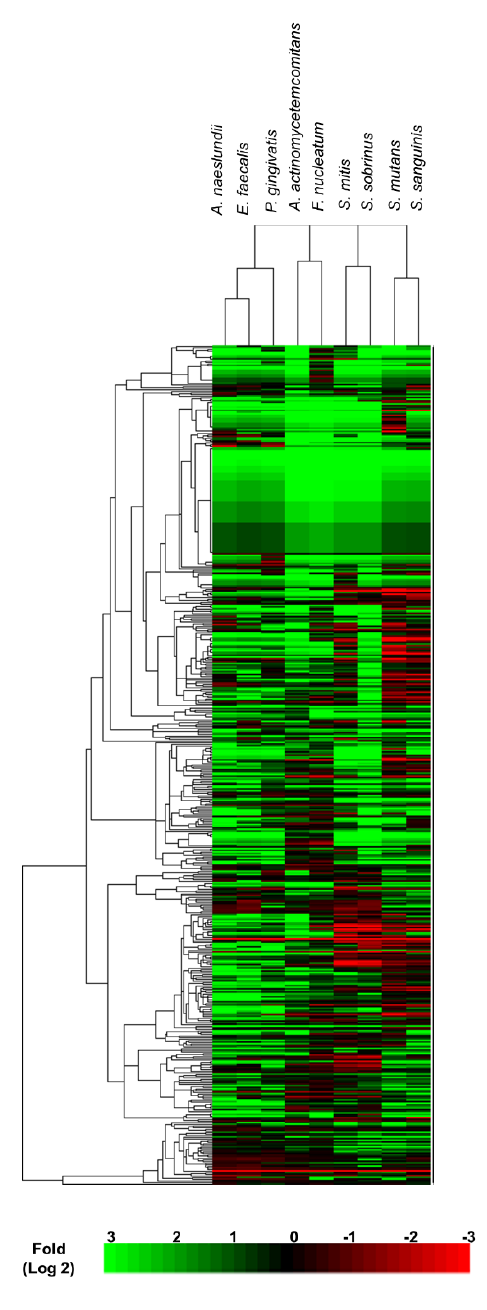
Figure 4. Cluster analysis of proteomic responses of C. albicans biofilms under bacterial exposures. Cluster software was used to estimate Euclidean distances between the proteomes and TreeView was used to illustrate the proteome profiles and linkages ( p -value < 0.05).